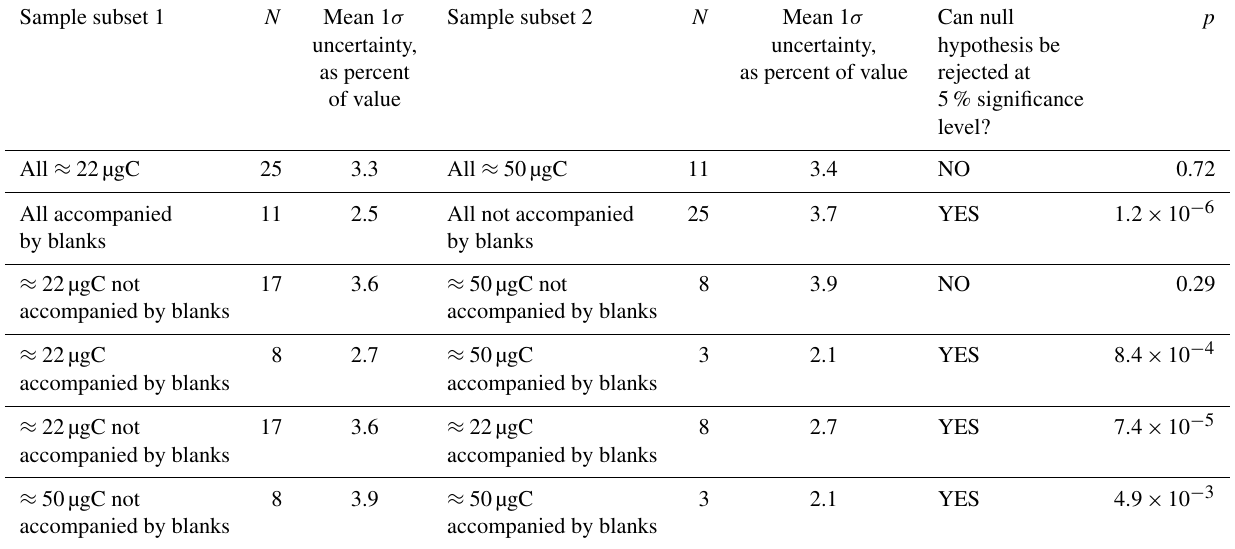
Table 1. Results of a two-sample t test investigating the effects of measured sample mass, whether the sample was accompanied by a blank, or both on the final relative uncertainty in the determined sample [ 14 CO] value. N is the number of samples in a particular subset. The null hypothesis is that the two subsets being compared are drawn from populations with equal means. The null hypothesis is rejected (i.e., the t test indicates that the means of the subsets are significantly different) if the probability ( p ) of the observed subsets occurring when the underlying populations have equal means is less than 0.05 ( <